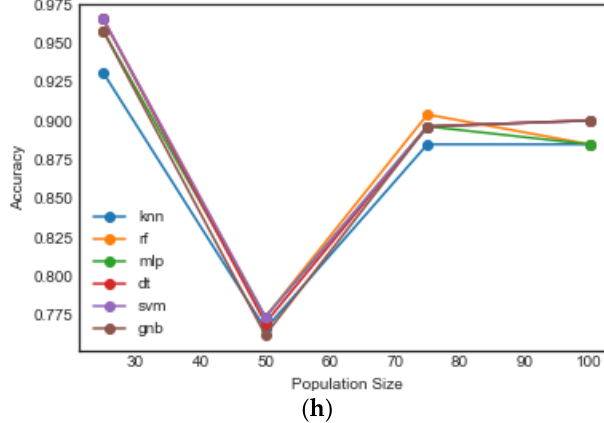
Figure 8. Classification accuracy of the KNN, RF, MLP, decision tree, SVM, and Naïve Bayes models with population sizes of 25, 50, 75, and 100 using the ( a ) BWOA,